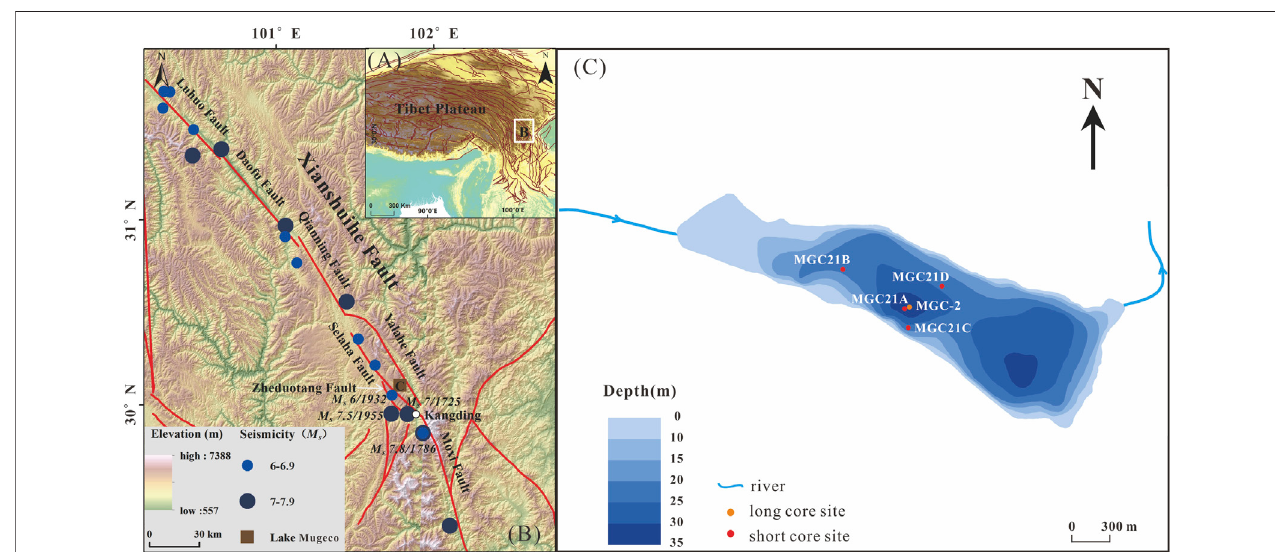
FIGURE 1 | Location of the study area. Location of the Xianshuihe fault in TP (A) . Seven fault segments and historical earthquakes along the fault (B) . Bathymetric map of Lake Mugeco and the location of sediment cores (C) .